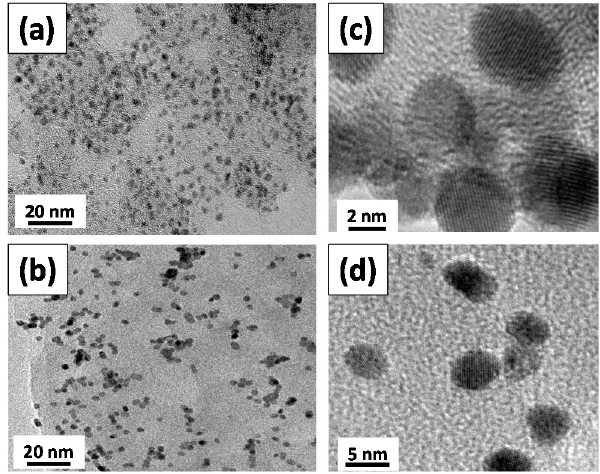
Figure 4. High-resolution transmission electron microscope (HR-TEM) micrographs of ( a , c ) Pd-GS and ( b , d ) Pd-rGO samples with low and high magnifications.